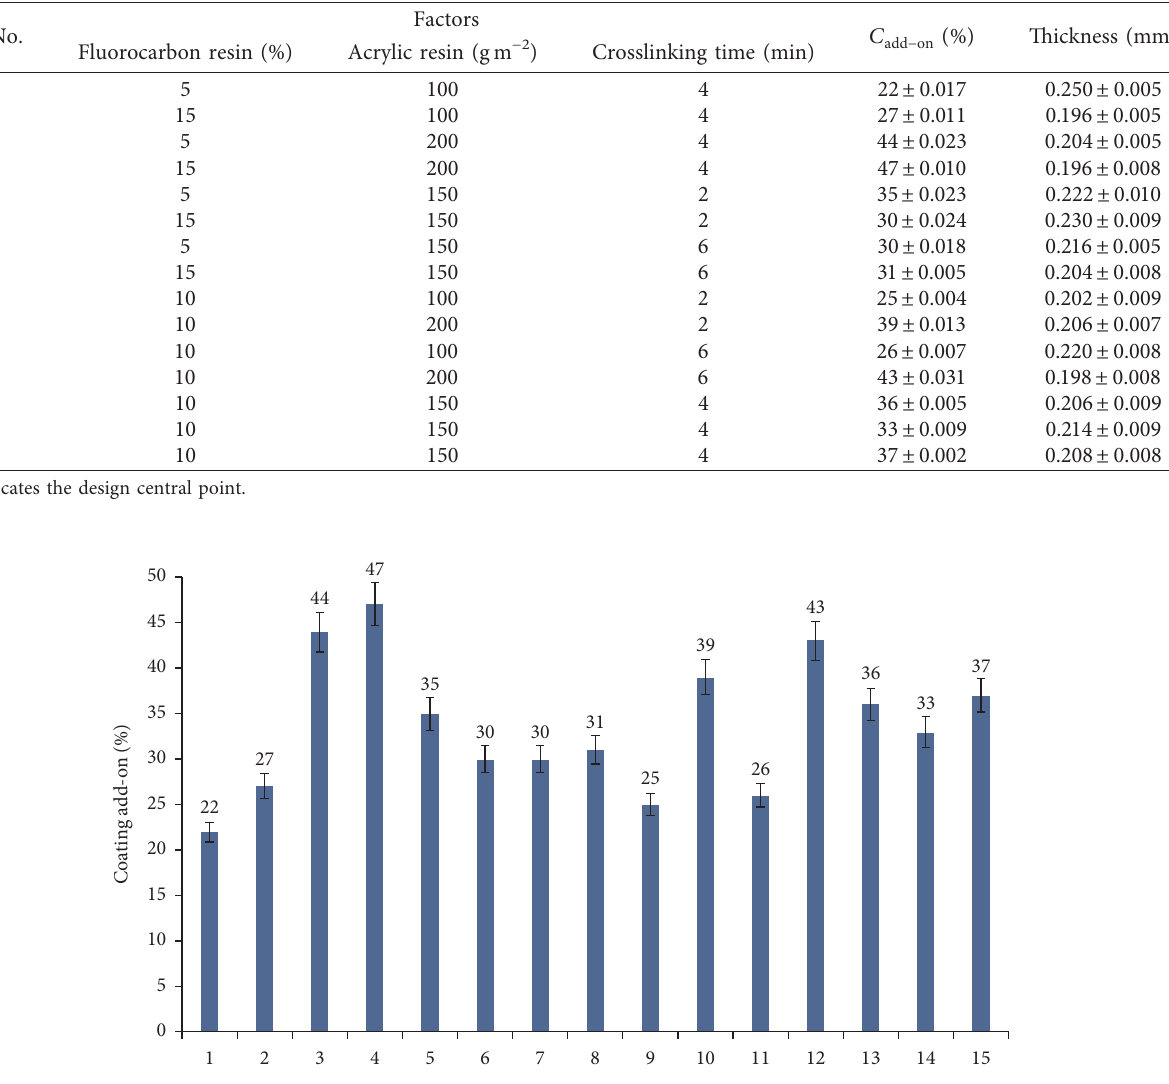
( % ) values for the coated woven fabric samples. add − on